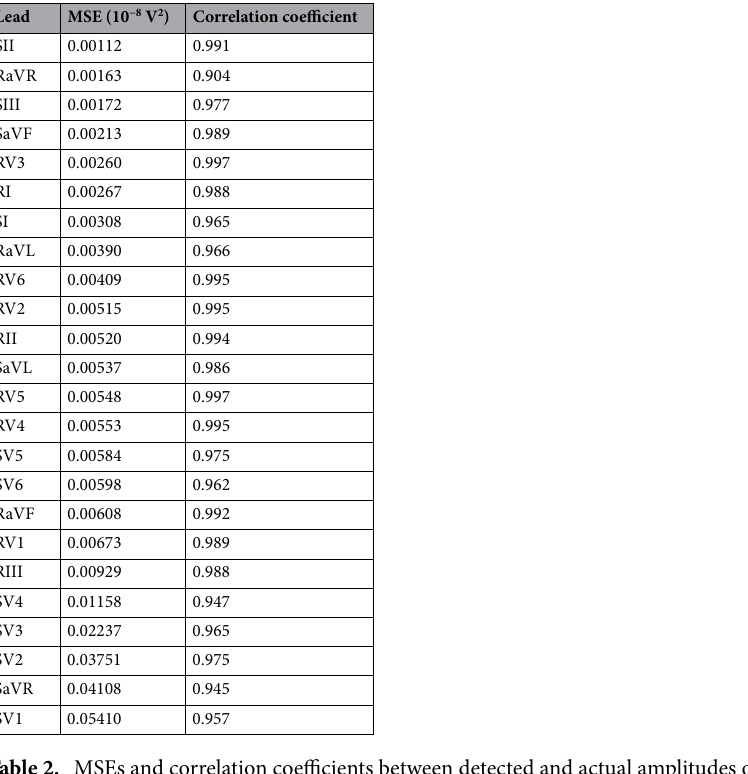
Table 2. MSEs and correlation coefficients between detected and actual amplitudes of R peaks and S valleys in each sequence of 12-lead ECG signals of 30 individuals.